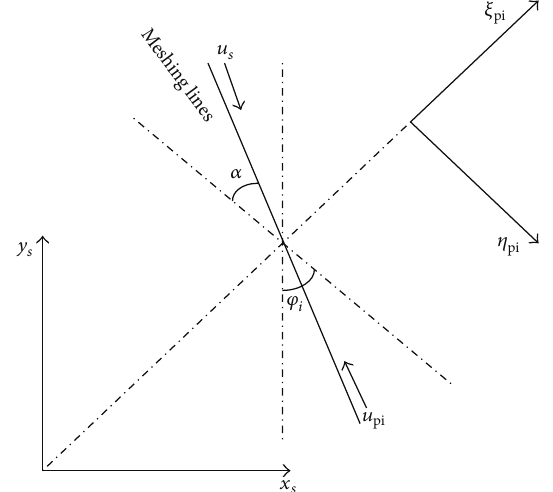
Figure 4: The geometry elastic relationship between pinion and bull